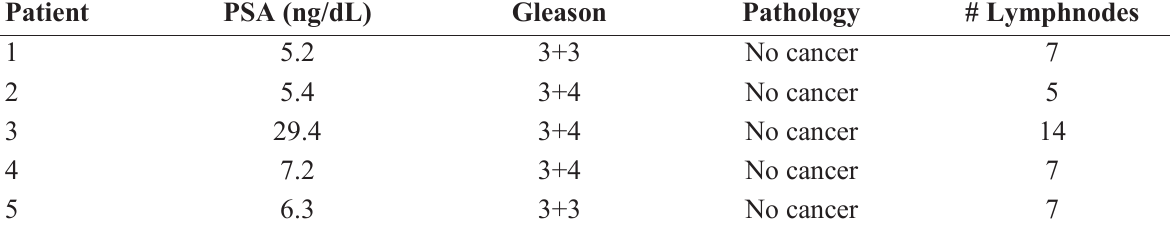
Table 3 - Pathology Results in Patients that underwent Laparoscopic Pelvic/Obturator